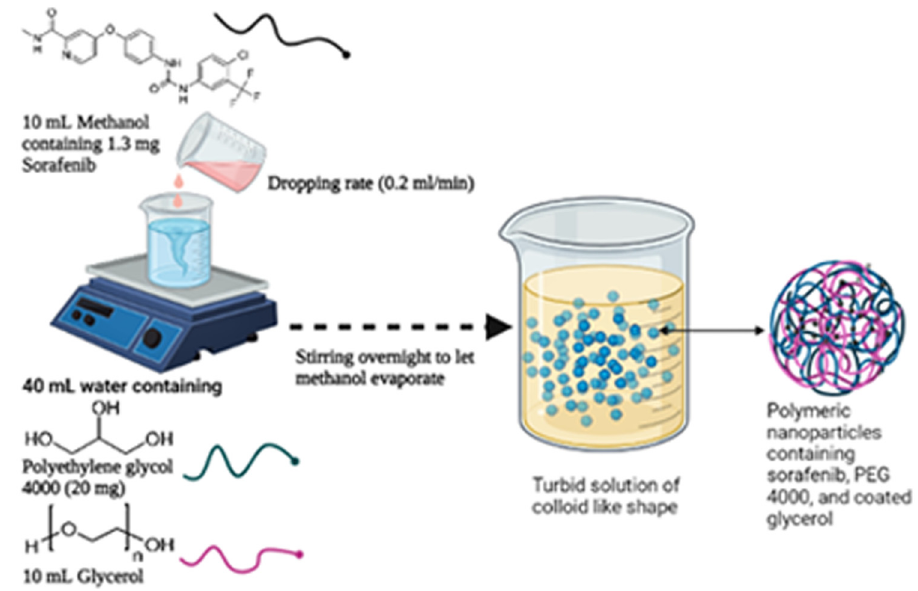
Figure 1: Schematic illustrating the preparation of SFB - NPs